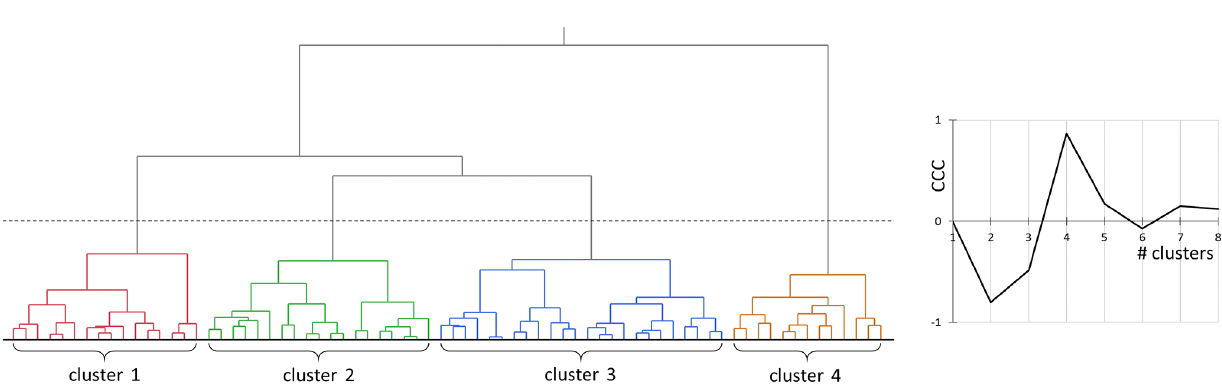
Figure 7. Hierarchical classification results.